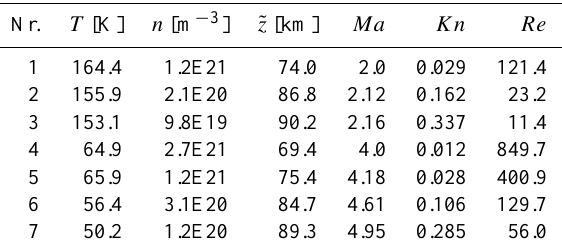
Table 3. Parameters of the wind tunnel experiments. ˜ z denotes the altitude which corresponds to the density in the experiment chamber. The altitude dependence of density has been taken from CIRA86 for the month July and a geographical latitude of 70 ◦ N (Fleming et al., 1990). Kn and Re have been calculated for L = 5 cm.